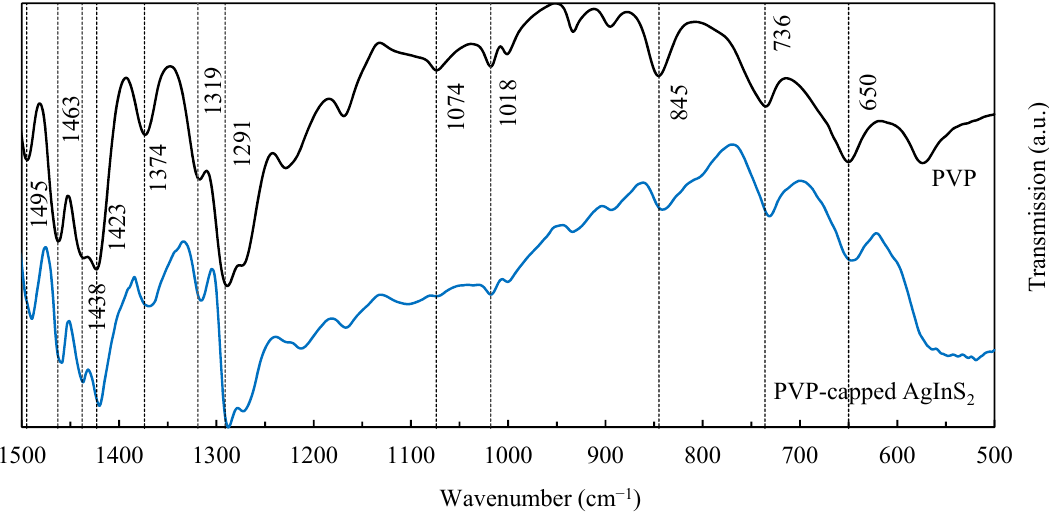
Figure 3. FTIR spectra of PVP and PVP-capped AgInS 2 QDs. The absorption bands that appeared at 1291, 1319, 1374, 1423, 1438, 1463, and 1495 cm − 1 were assigned to the vibration in the PVP heterocycle [22]. The bands at 1074 [23] and 1018 cm − 1 were the result of the C–N stretching vibration; the bands at 845, 736, and 650 ging, respectively.